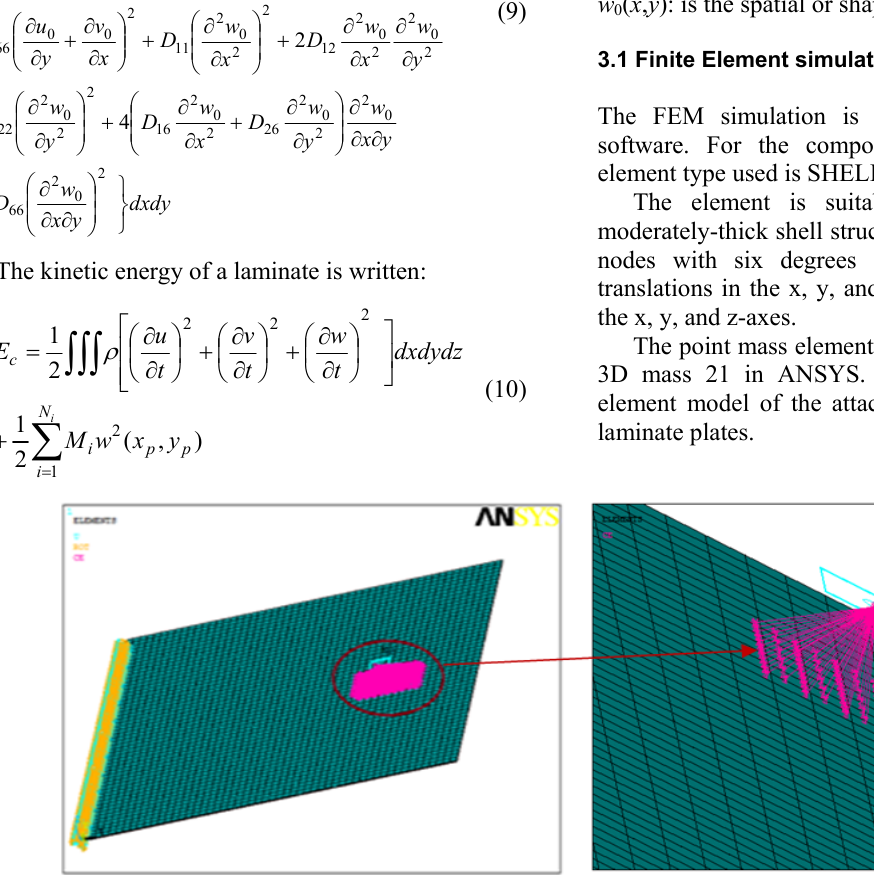
Figure 5. Finite element model of composite laminate plates with mass